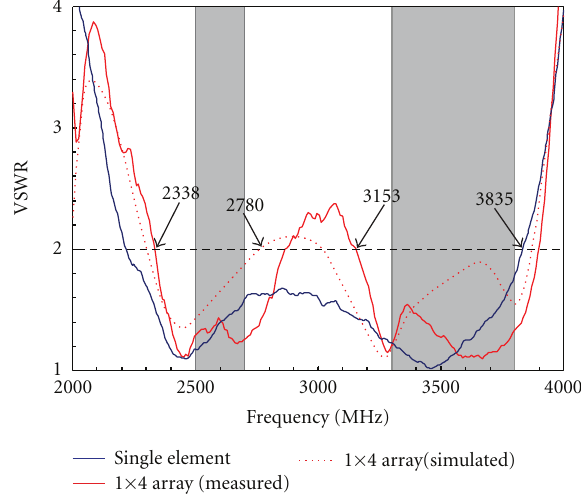
Figure 2: Simulated and measured VSWR against frequency for the proposed planar dual-band dipole array.